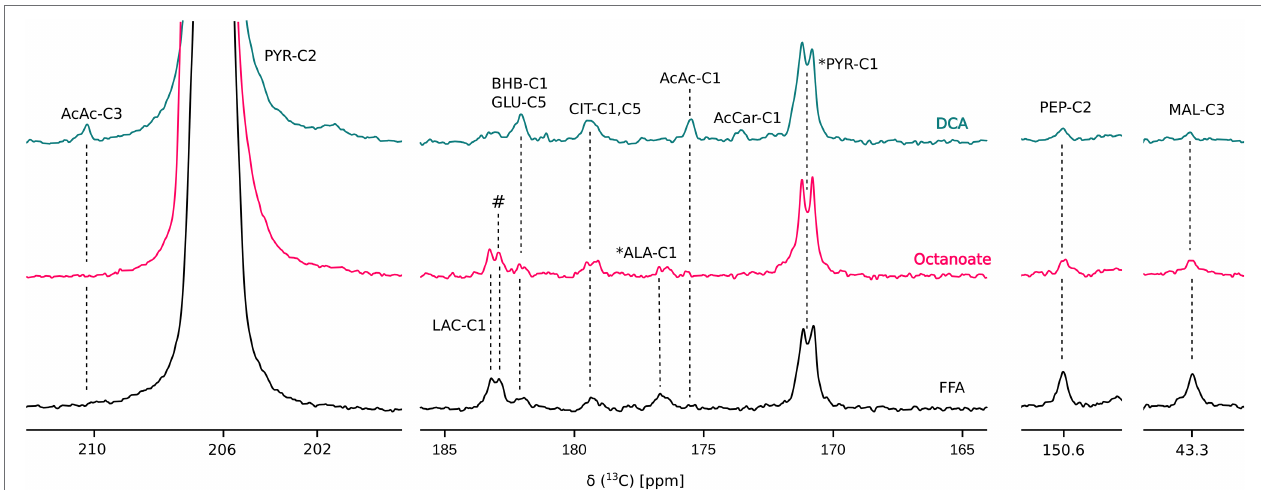
FIGURE 1 | Overlay of representative 13 C sum spectra following injection of HP [2- 13 C] pyruvate. AcAc, acetoacetate; AcCar, acetyl carnitine; ALA, alanine; BHB, 3-hydroxy butyrate; CIT, citrate; GLU, glutamate; LAC, lactate; and PYR, pyruvate. # and * represent unidentified and natural abundance signals, respectively. “DCA” is Dichloroacetate. Perfusion conditions and NMR parameters are described under Materials and Methods section. Resonance assignments were confirmed using [ 1 H, 13 C] HSQC and [ 1 H, 13 C] HMBC